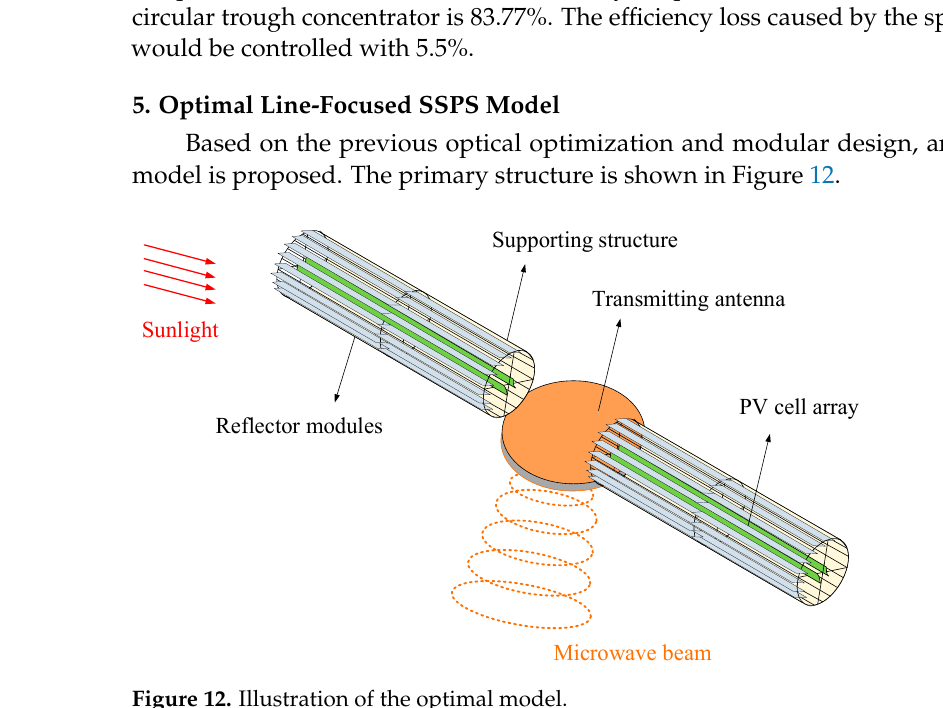
Figure 13. Detailed structure: ( a ) power management and distribution system; ( b ) transmitting antenna.